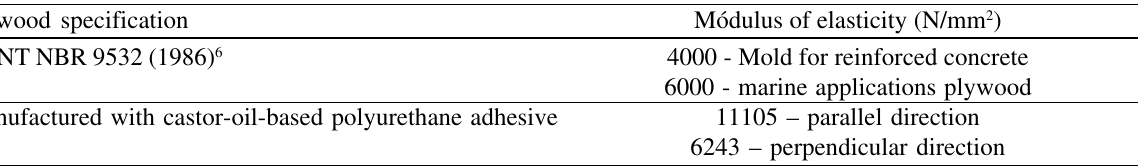
Table 7. Comparison between values of the alternative plywood properties with specified by